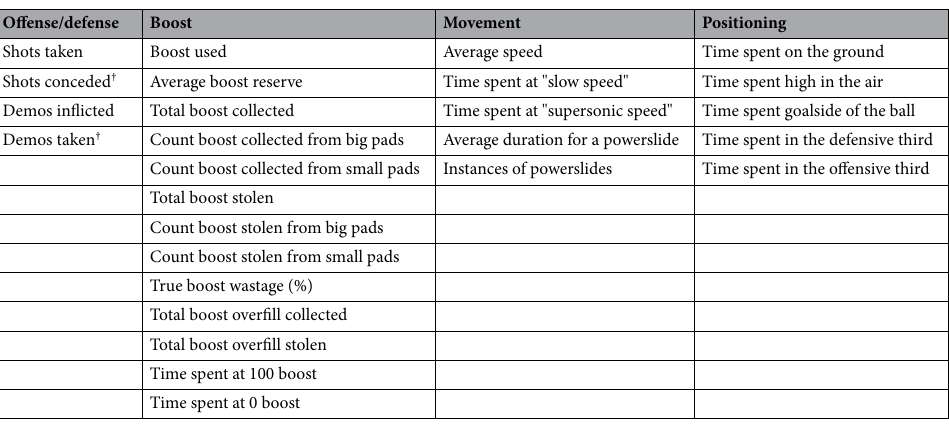
Table 2. Predictor metrics obtained through “www. ballc hasing. com” and subsequent processing. Metrics are time normalised to an average match length (360 s) unless provided as a percentage of total time in the original dataset, Metrics are expressed both as “raw-score” and “difference-score” except those denoted by a † , which are “raw-score”